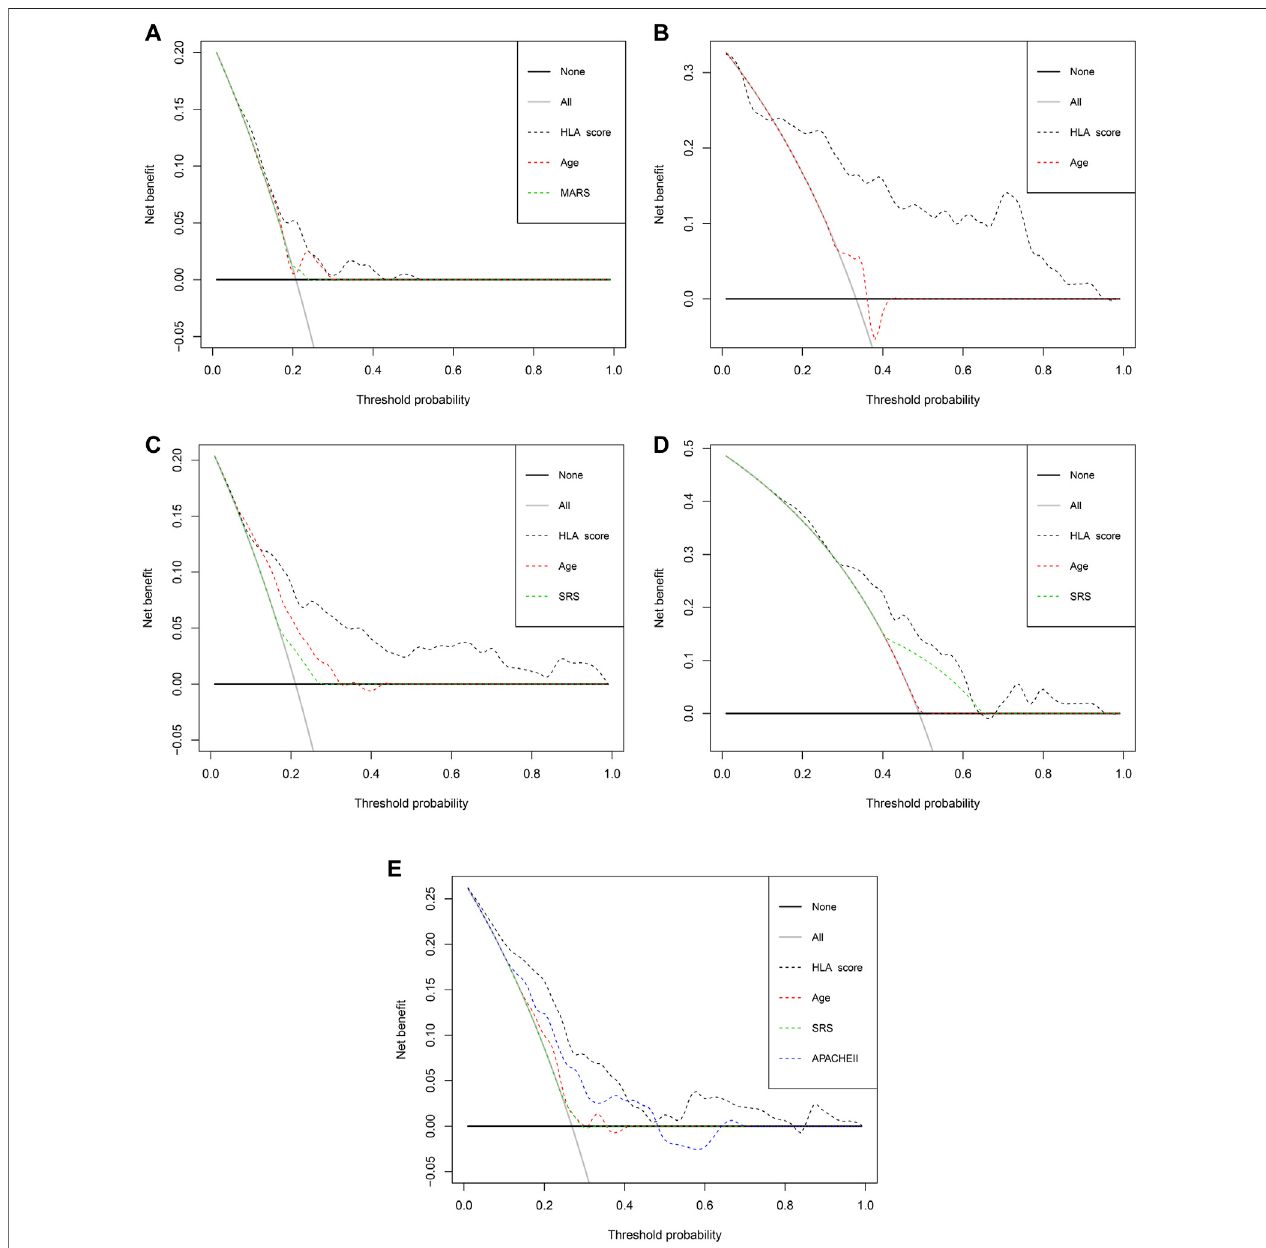
FIGURE 5 | The evaluation of the clinical usefulness of the HLA classi fi er compared with age, SRS, MARS, and APACHE II in the discovery and external validation cohorts. (A) GSE65682 datasets. (B) GSE95233 datasets. (C) E-MTAB-4421 datasets. (D) E-MTAB-4451 datasets. (E) E-MTAB-7581 datasets.